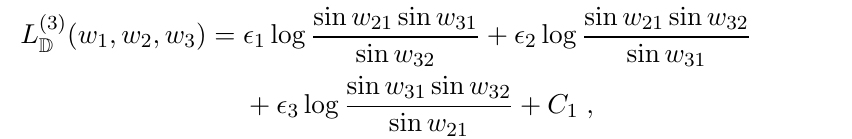
Figure 6 . N=2 and other